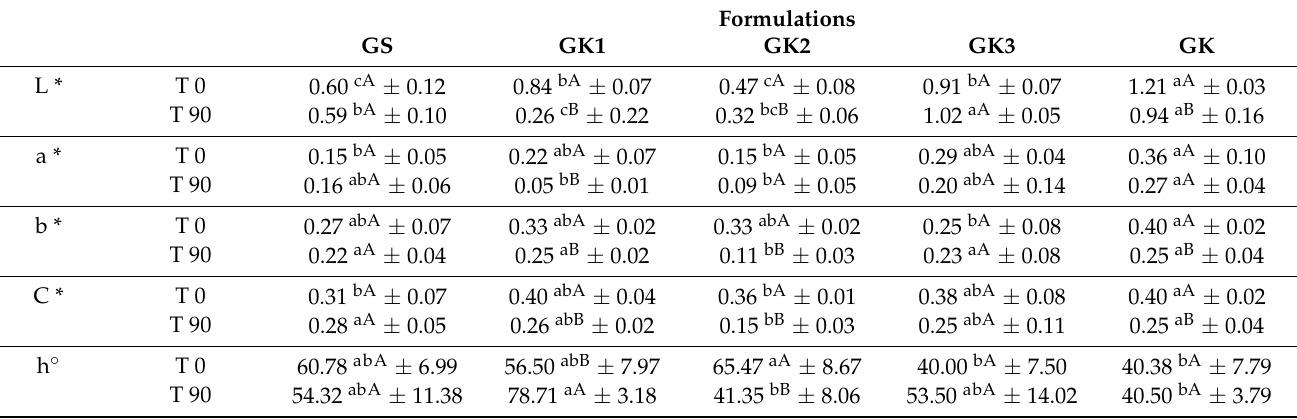
Table 6. Instrumental color parameters (L *, a *, b *, C * and H ◦ ) of ice creams after 0 and 90 days of storage.